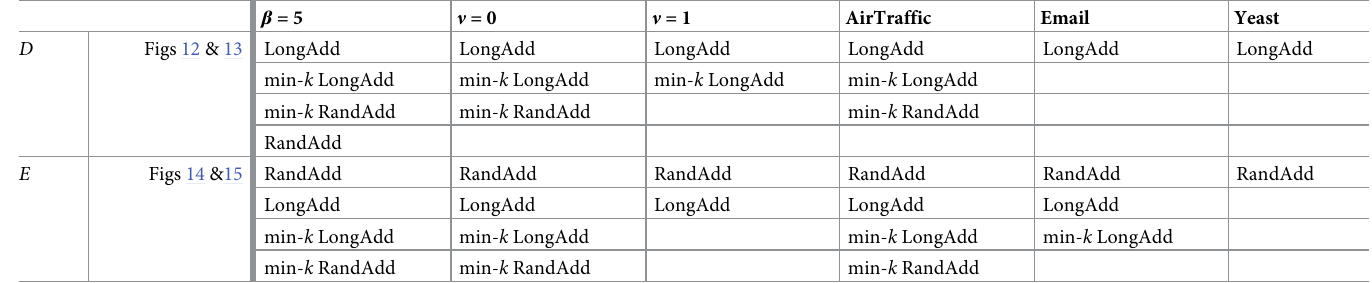
Table 5. The most effective methods for decreasing D and increasing E to random trees and real networks. β =